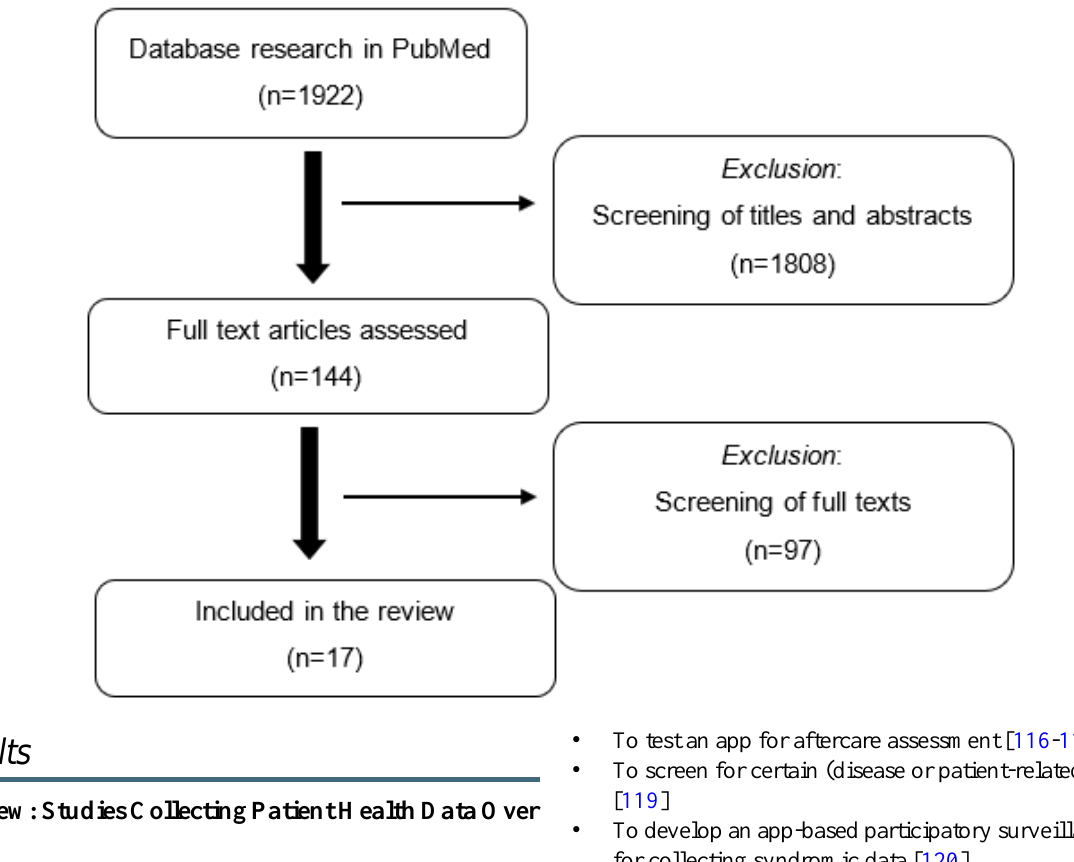
Figure 1. Flowchart of the scoping